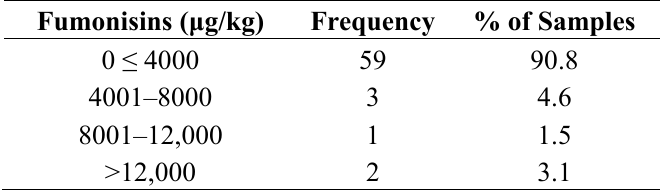
Table 4. Distribution of total fumonisins levels in maize kernel samples.